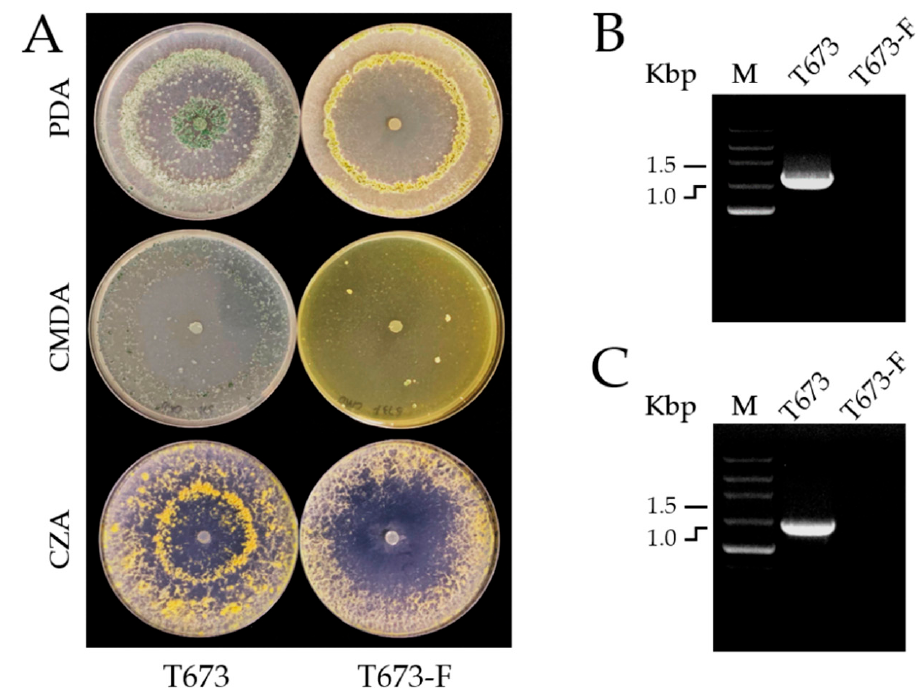
Figure 3. Characterization of ThPV2-infected and cured Trichoderma harzianum strains T673 and T673-F. ( A ): Colony morphology of strains T673 and T673-F on PDA, CMDA and CZA. ( B ): Amplification of a ~1.69 and ( C ): of a ~1.46 Kb ds-RNA genome fragments by RT-PCR in strain T673, but not in strain